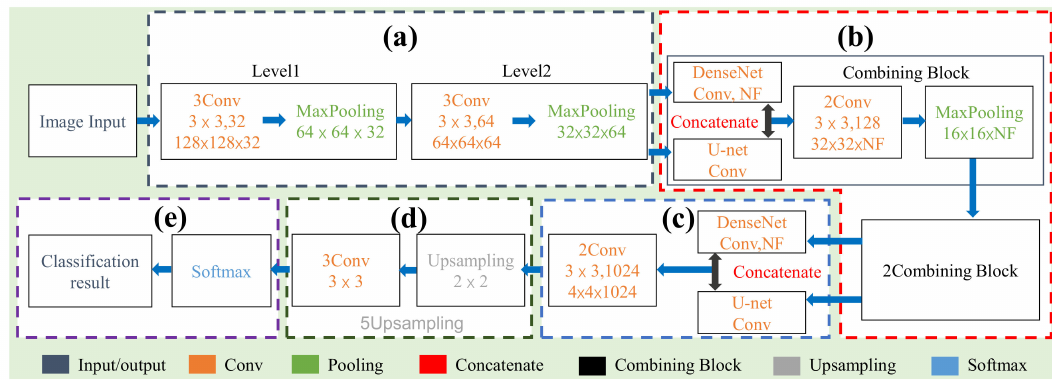
Figure6. ThenetworkstructureoftheUDNalgorithm, whereNFrepresentsthenumberofconvolutional